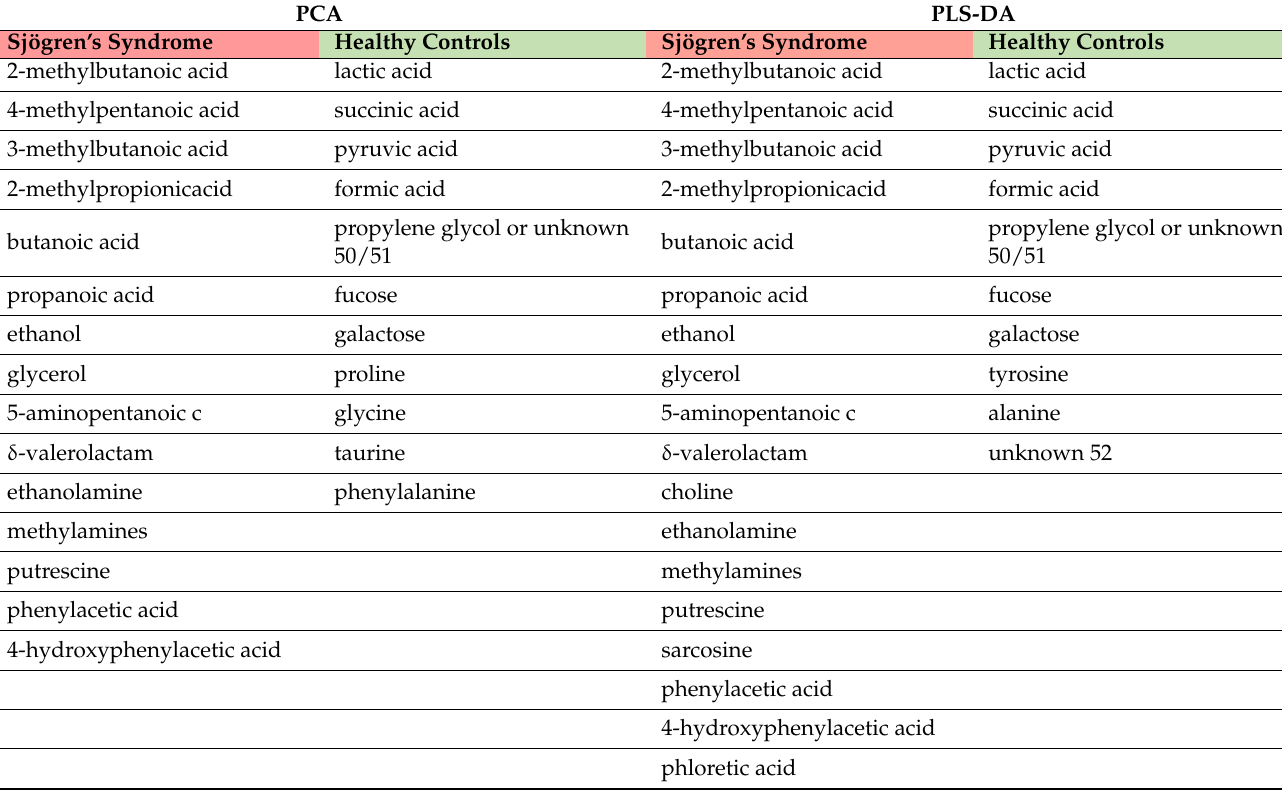
Table 2. Most significant metabolites in each group (red, pSS; green, HCs) obtained by PCA and